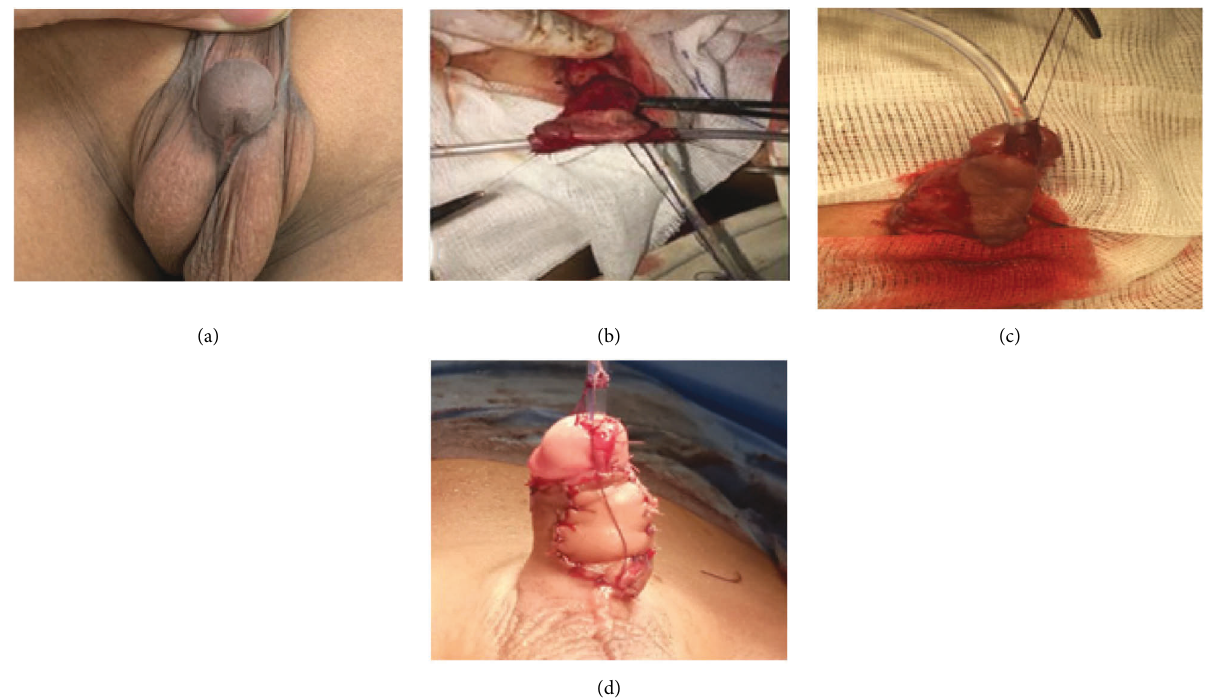
Figure 1: Steps of the double-faced preputial flap (DFPF) technique. (a) Penoscrotal hypospadias. (b) Preputial flap is tubularized over Nelaton’s catheter. (c) Pedicle of the flap completely dissected off dorsal shaft skin and corpora down to the penopubic angle. The neo- urethral tube with still attached outer preputial layer of the flap is transposed to the ventral aspect of the penis. (d) Outer preputial layer of the flap is trimmed and sutured to the remaining dorsal shaft